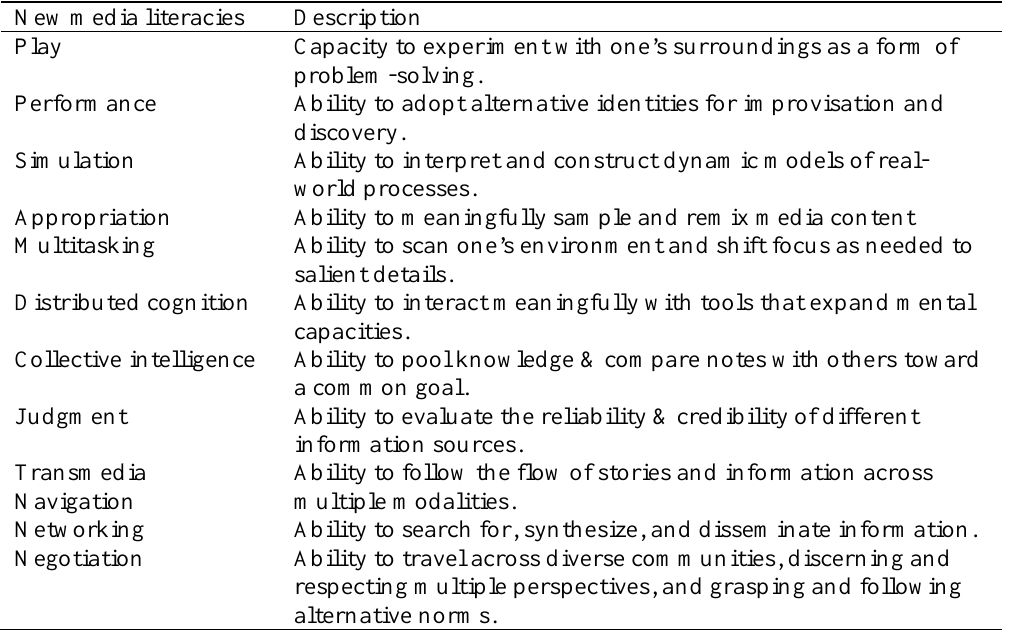
Overview of New Media Literacies (Jenkins et al.,